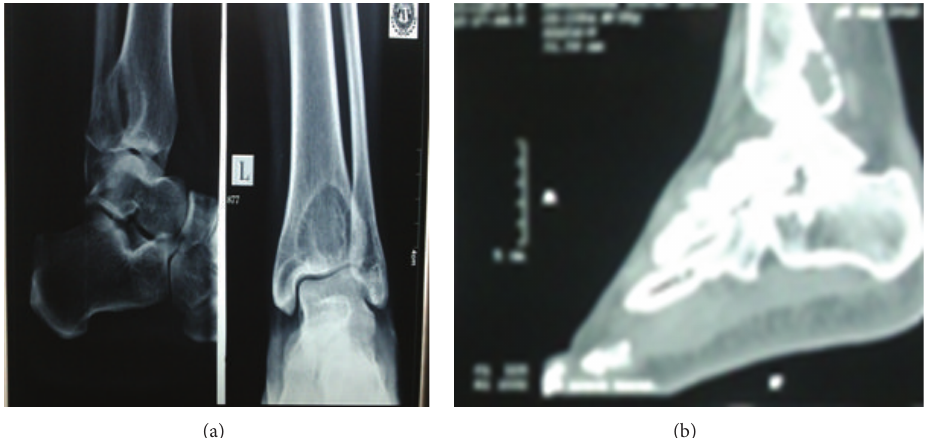
Figure 1: Preop X-ray and CT scan showing osteolytic lesion of distal tibia.